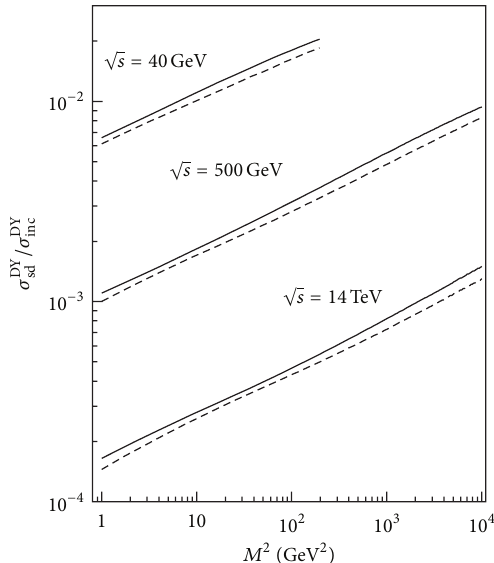
Figure 8: The single diffractive-to-inclusive DY cross sections ratio as a function of the photon virtuality 𝑀 2 for 𝑥 1 = 0.5 (solid lines) and 𝑥 1 = 0.9 (dashed lines) and c.m.s. energies √𝑠 = 40 GeV, 500 GeV, and 14 TeV (from top to bottom)